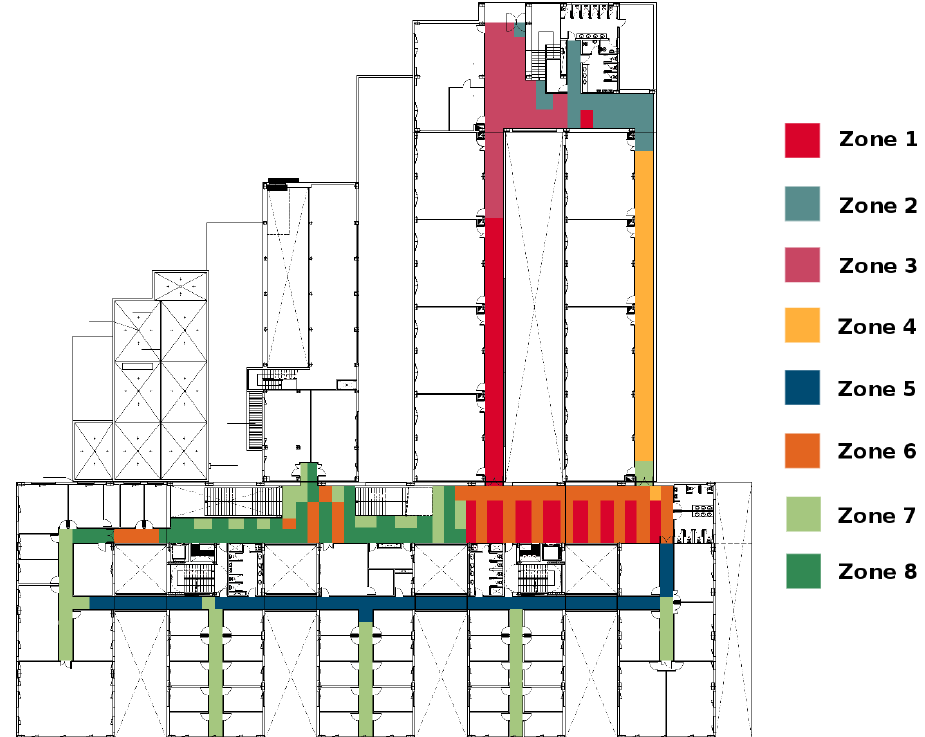
Figure 8. Zones in Building A identified with the EM algorithm using the intensity parameter of the magnetic